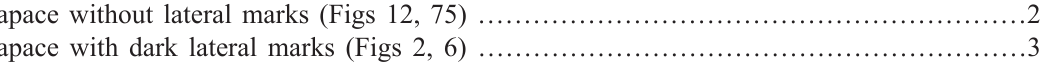
1. – 2. Male clypeus with single median process (Fig. 63); genital bulb with two processes in opposing directions (Fig. 65); male palpal tibia unusually slender (Huber 2005: fig. 138); epigynum posterior margin projecting medially (Figs 32, 72) …… S. tessellata (Simon, 1901) – Male clypeus with pair of rounded processes at rim (similar to S. kaeo sp. nov., cf. Fig. 20); bulb with single process (Figs 79, 81); male palpal tibia ‘normal’, i.e., not unusually slender (Fig. 81); epigynum posterior margin without median projection (Figs 34, 84) … S. miser (Bristowe, 1952) 3. Male genital bulb with two long processes in opposing directions (Fig. 50); epigynum with prominent median process (Fig. 54) ………… S. kraburiensis Wongprom & Wiwatwitaya, 2015 – Male genital bulb with only one process or with much shorter processes (Figs 14, 22, 60); 4. Male palpal procursus strongly curved (Huber 2005: fig. 132); male clypeus with very indistinct pair of lateral processes at rim (Fig. 55); epigynum evenly curved, without lateral posterior – Male palpal procursus weakly curved (Fig. 15); male clypeus with distinct pair of lateral processes at rim provided with hair brushes (Fig. 20); epigynum with pair of lateral humps near